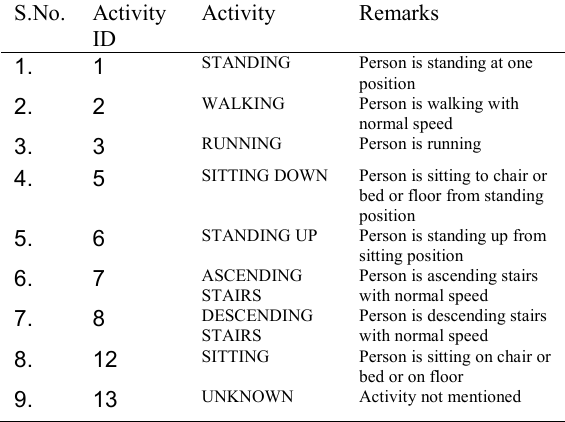
Figure. 8 Execution Time Chart of ML